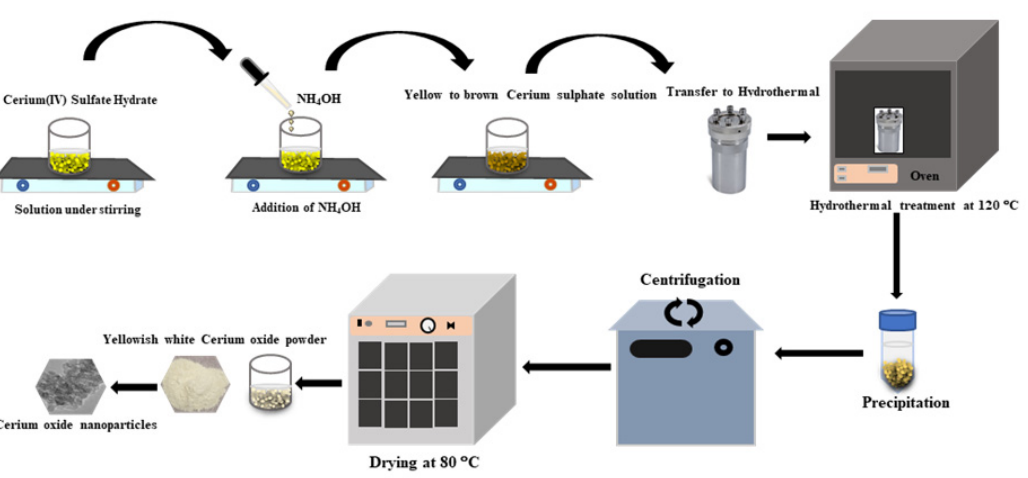
Figure 1. Schematic diagram demonstrating the steps of nanoceria (NC) synthesis using the hydrothermal method.